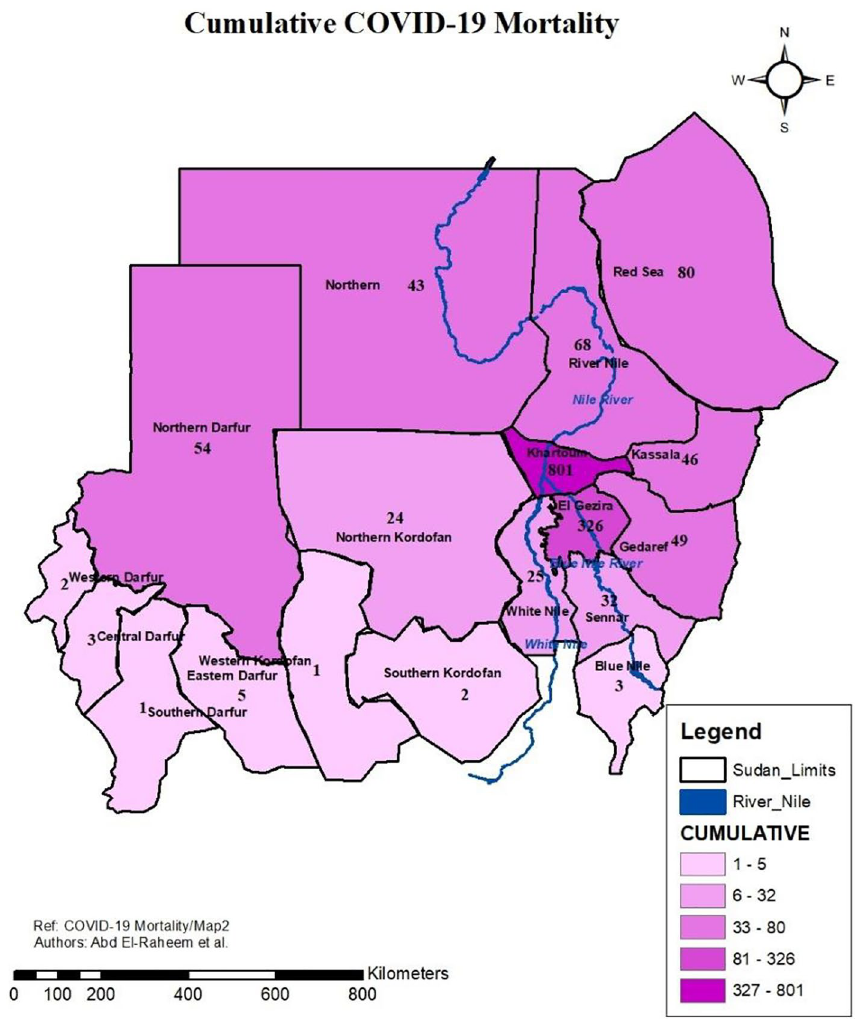
Figure 4. Cumulative COVID-19 Mortality across the Sudan States developed through ArcGIS 10.8 by Abd El-Raheem et al. (Shp. files of the base maps https:// www. diva- gis. org/